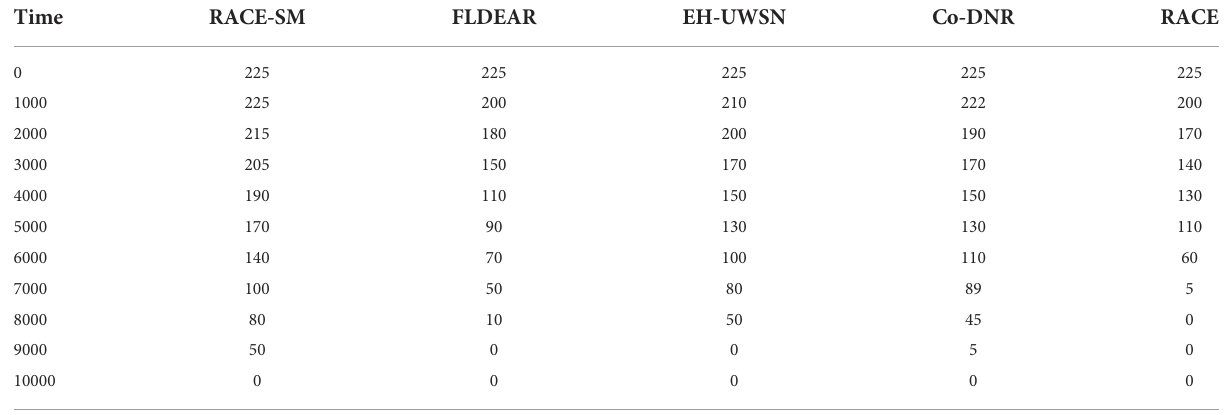
TABLE 4 Protocols addressing Live Nodes.